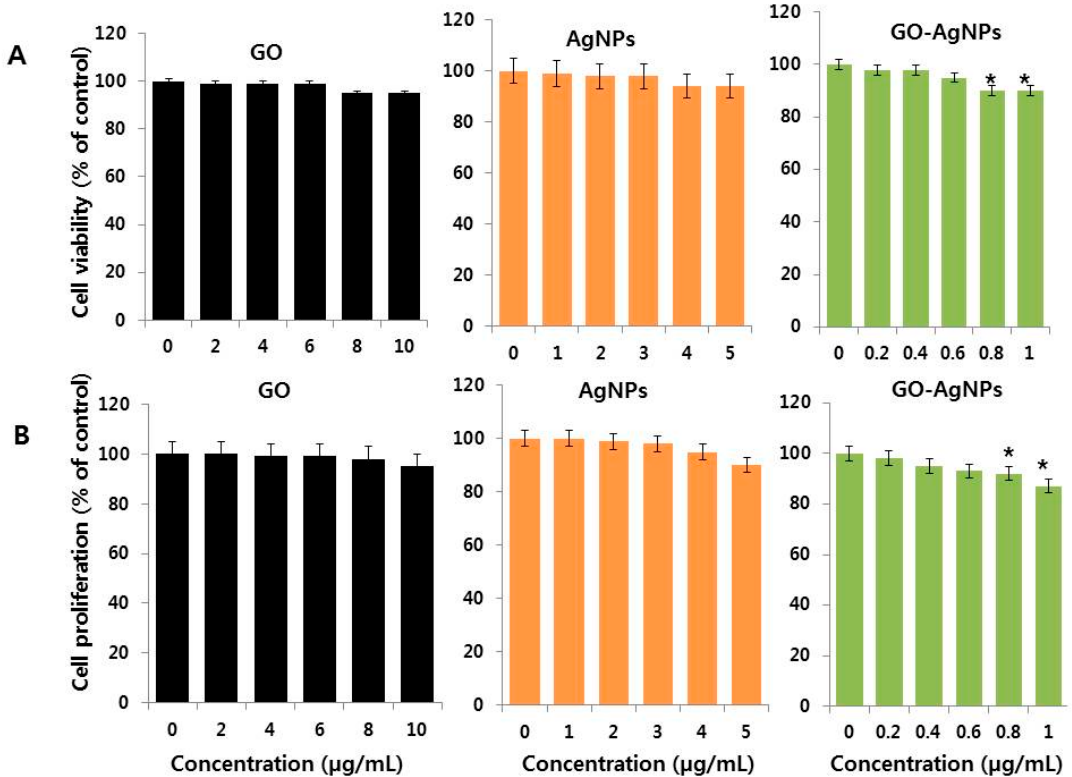
Figure 2. Effect of low concentration of GO-AgNPs on cell viability and proliferation of SH-SY5Y cells. ( A ) The viability of SH-SY5Y cells was determined after 24-h exposure to different concentrations of GO (2–10 µg/mL), AgNPs (1–5 µg/mL) and GO-AgNPs (0.2–1.0 µg/mL) using the CCK-8 assay; ( B ) Cell proliferation of SH-SY5Y cells was determined after 24-h exposure to different concentrations of GO (2–10 µg/mL), AgNPs (1–5 µg/mL) and GO-AgNPs (0.1–1.0 µg/mL) using trypan blue exclusion